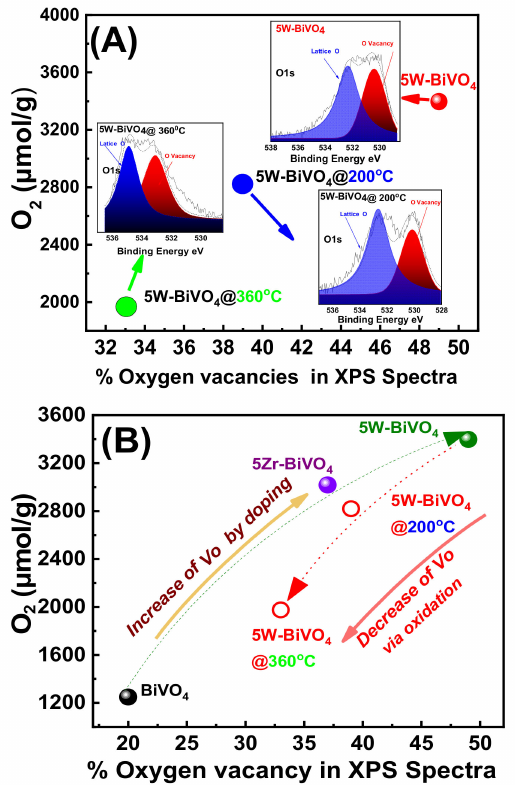
Figure 8. Photocatalytic O 2 -evolution evolution vs. the O-vacancies in the doped-BiVO 4 catalysts. ( A ) Increase of O-vacancies is promoted by W- or Zr-doping in FSP-made BiVO 4 . Insert: O1s XPS spectra of the W-doped BiVO 4 . ( B ) Calcination under O 2 -rich atmosphere (oxidation) results in decrease of O-vacancies.